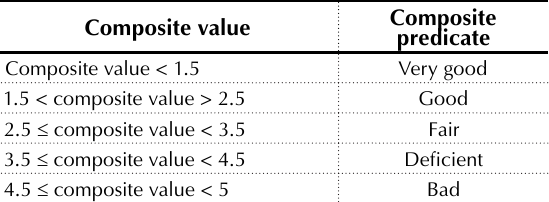
Table 1. Composite value of GCG self-assessment according to Bank